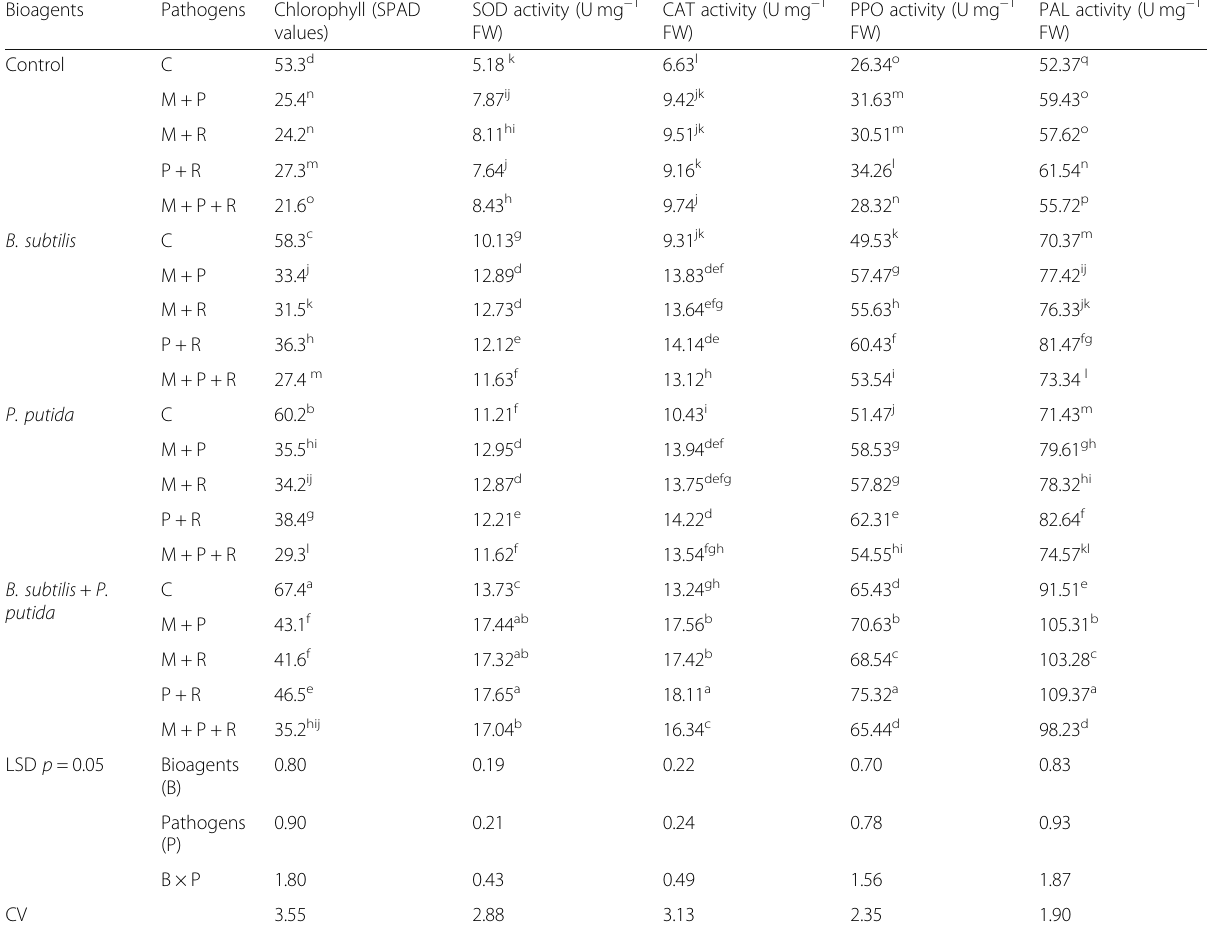
Table 5 Influence of Pseudomonas putida , Bacillus subtilis , and their mixtures on the chlorophyll content, and the activities of SOD, CAT, PPO, and PAL of beetroot infected with two/three pathogens simultaneously in a disease complex incited by Meloidogyne incognita , Pectobacterium betavasculorum , and Rhizoctonia solani